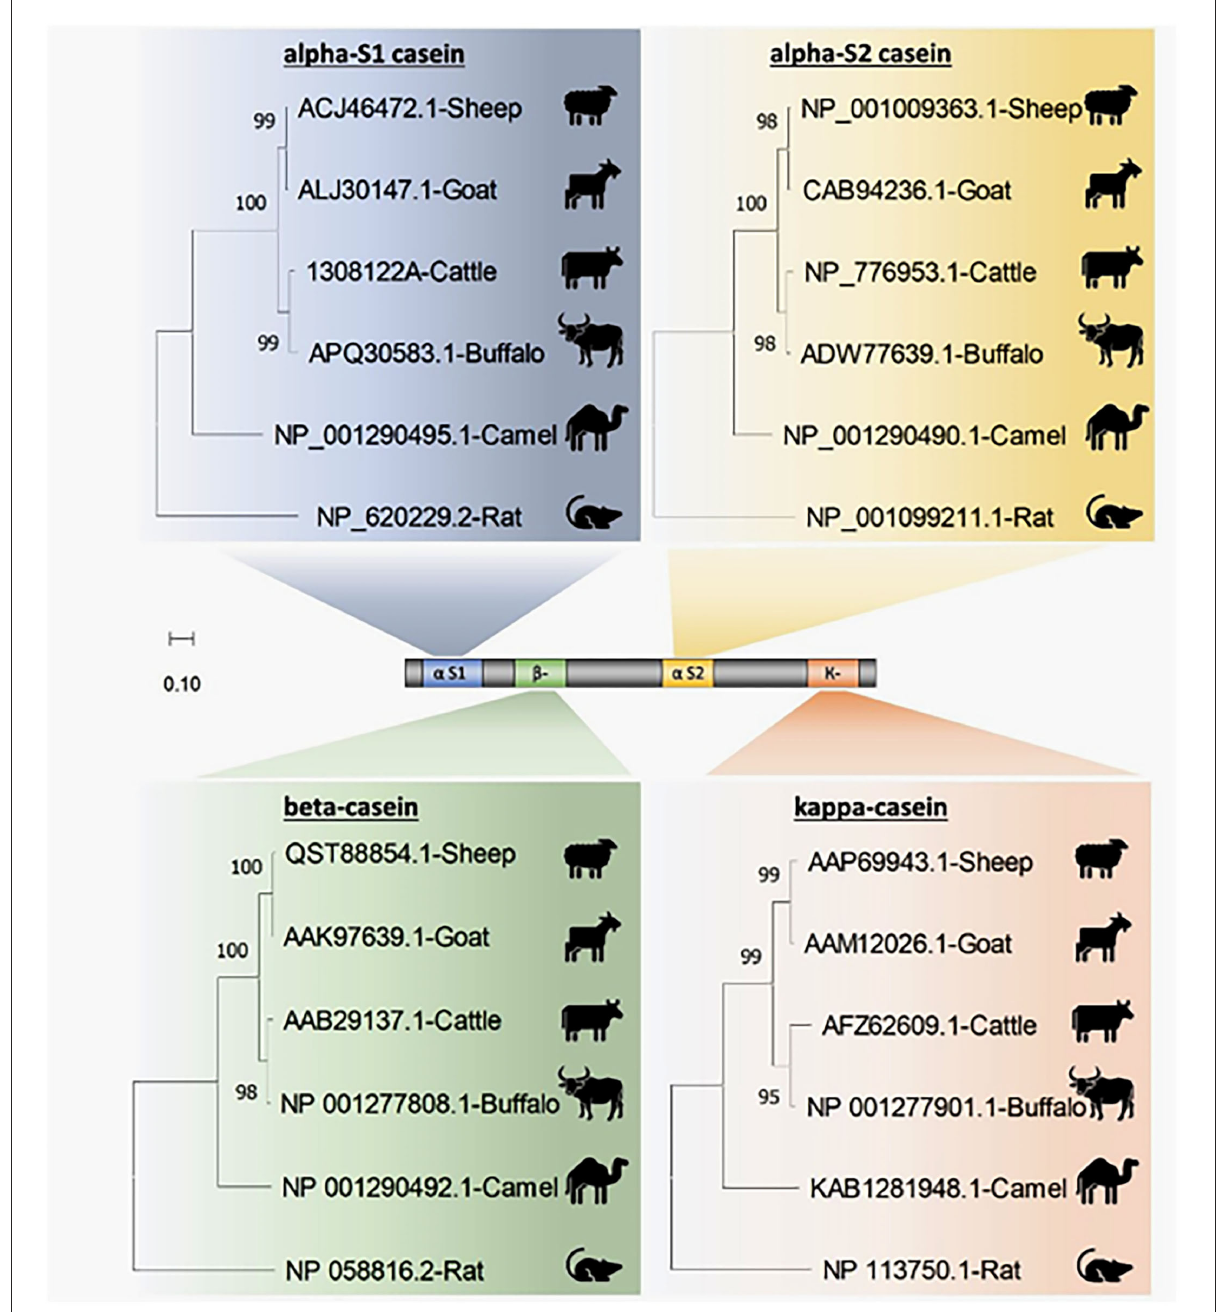
FIGURE1 Phylogenetic analysis of casein subunits from different domestic animals. A neighbor-joining tree representing the phylogenetic relationship of sheep, goats, cattle, Arabian camels, and water buffalos was derived from the alignment of alpha-S1-, alpha-S2-, beta-, and kappa-casein amino acid sequences. The tree was rooted in Rattus norvegicus. Bootstrap support values are indicated on the nodes. Bootstrap values were calculated from 1,000 replications.